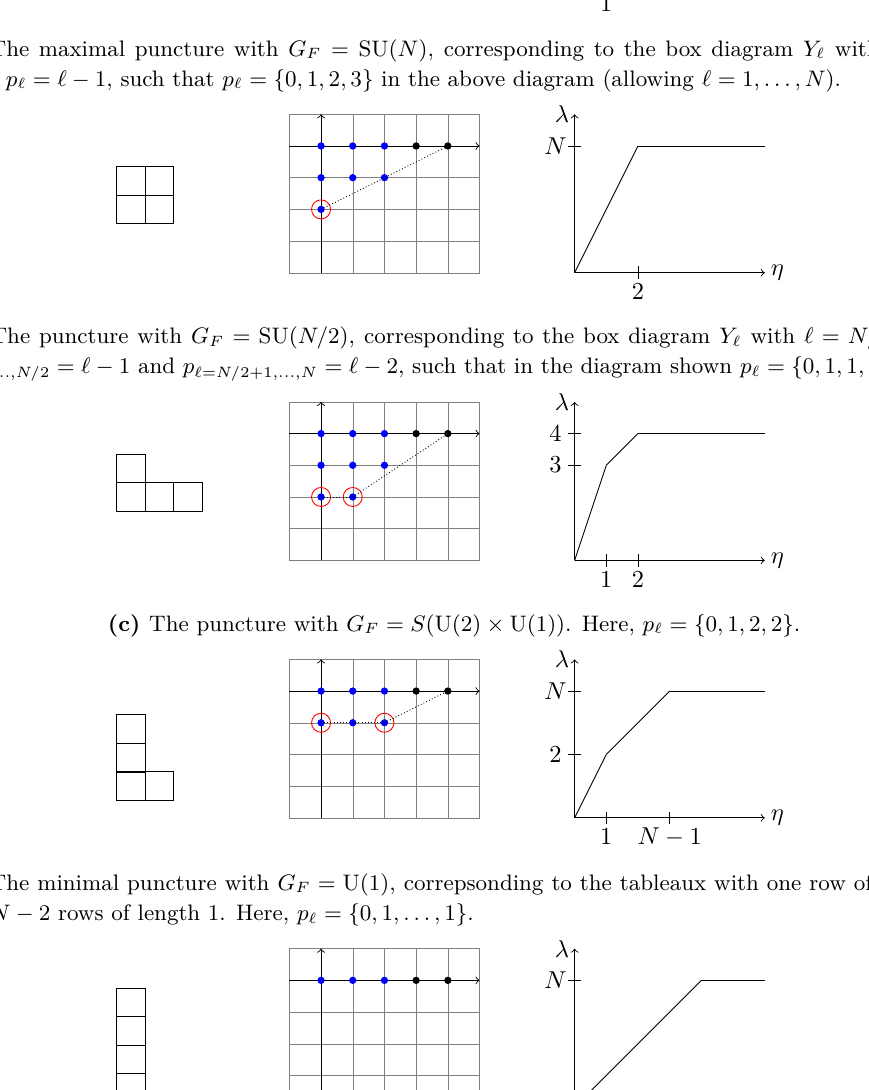
(e) The non-puncture, corresponding to the box diagram Y ‘ with ‘ = 1 . Here, p ‘ = 0 for all ‘ . Figure 8. The Young tableaux, Newton polygons, and charge density profiles λ reg of the possible regular punctures for N = 4 . The blue dots represent deformation parameters of the Seiberg-Witten curve. The red circled dots are the Coulomb branch operators O identified in a